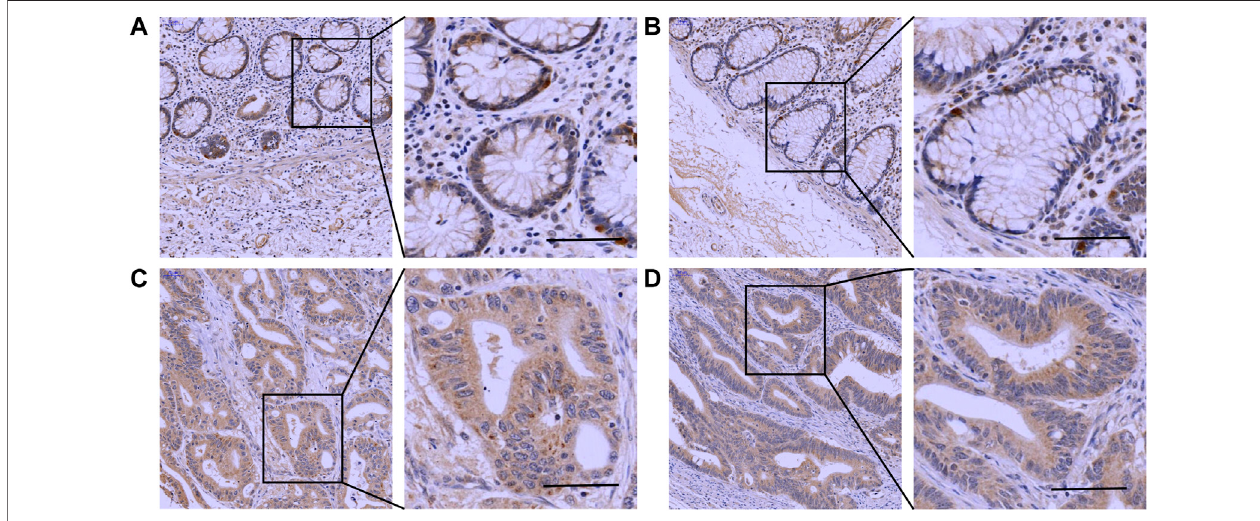
FIGURE 10| Immunohistochemical validation ofMapk14expression in M-stage colorectal cancer tissuesand normal tissues. (A,B) Mapk14 expression in normal tissues. (C) Mapk14 expression in M0-stage CRC tumor tissues. (D) Expression of Mapk14 in M1-stage CRC tumor tissues. (Left: SP × 200; Right: magni fi ed view).